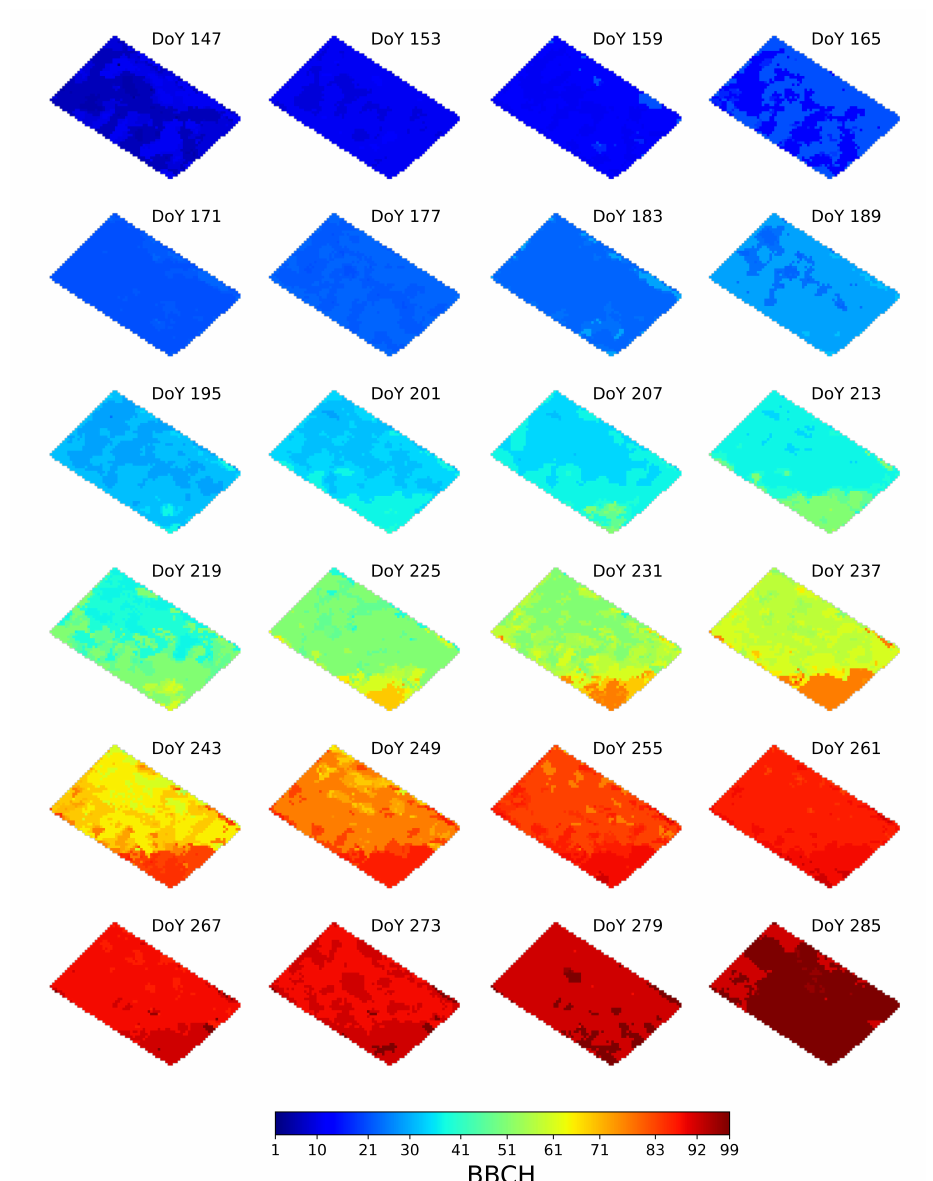
Figure 8. Pixel-level phenology estimates at the S1 acquisition dates obtained with the proposed approach for the parcel BEST. The DoY of each acquisition is